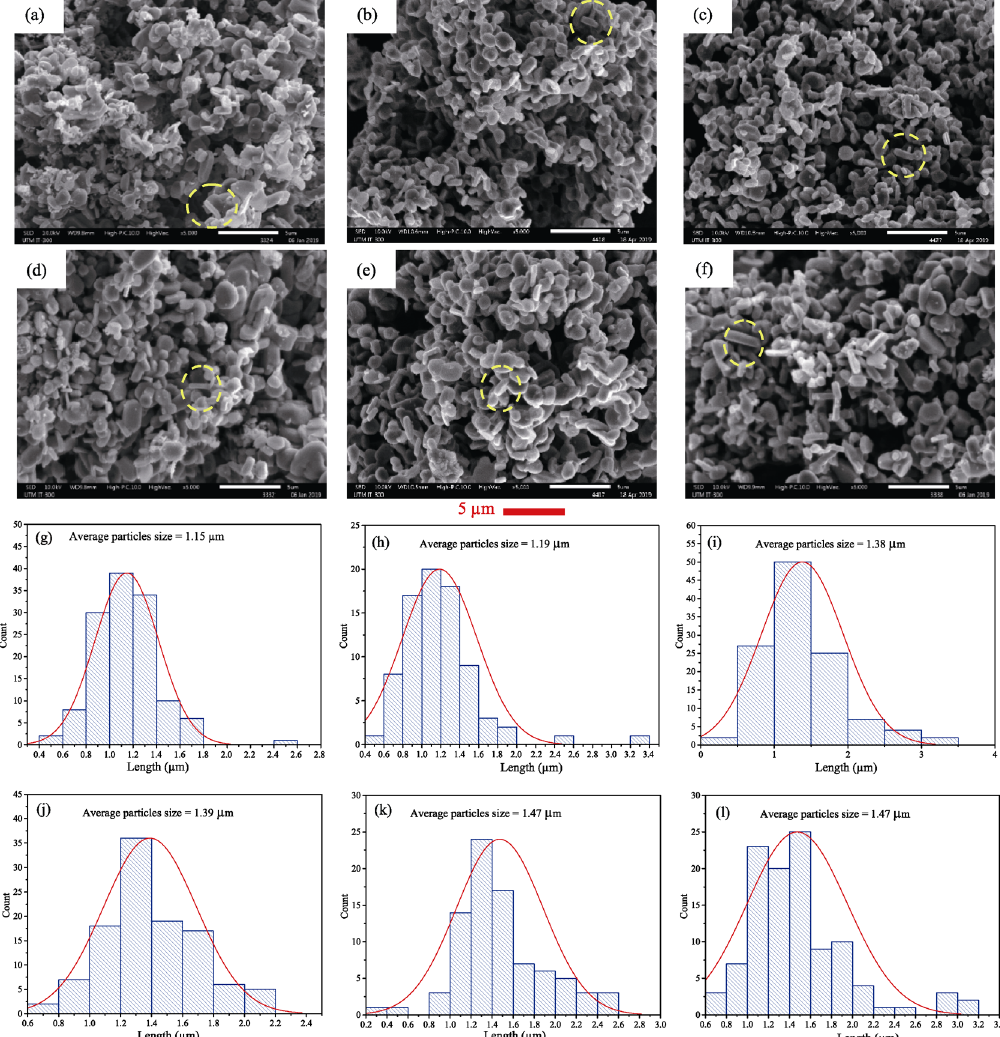
Fig. 5 VP-SEM micrographs of Ca 3 Co 4 O 9 powder calcined at 1073 K with different calcination time (a) 4, (b) 6, (c) 8, (d) 10, (e) 12, and (f) 14 h and their particle size distribution in (g–l), respectively. Yellow circles indicate plate-like